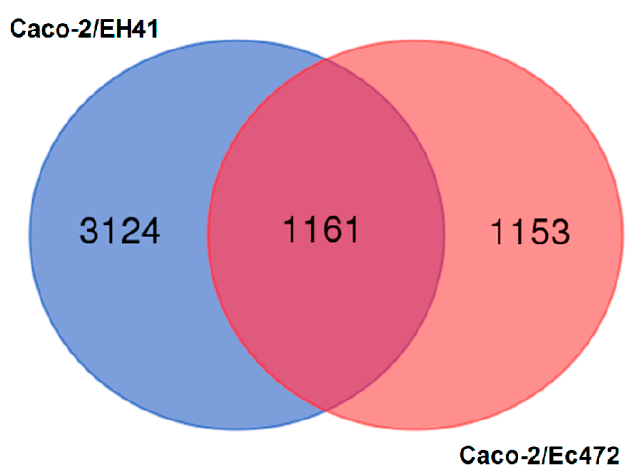
Figure 2. Differential gene expression analysis of Caco-2 cells during three hours of enterocyte–STEC interaction. Venn diagram for differentially expressed (DE) genes in Caco-2 / EH41 and Caco-2 / Ec472 groups. Total DE genes were used for constructing ten GCNs for Caco-2 / EH41 and for Caco-2 /